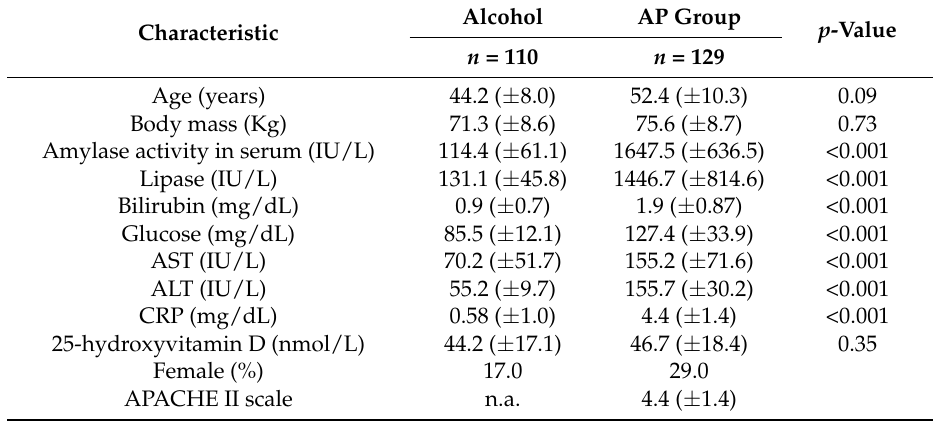
Table 3. Distribution of selected characteristics in acute pancreatitis patients and alcohol-abuse control